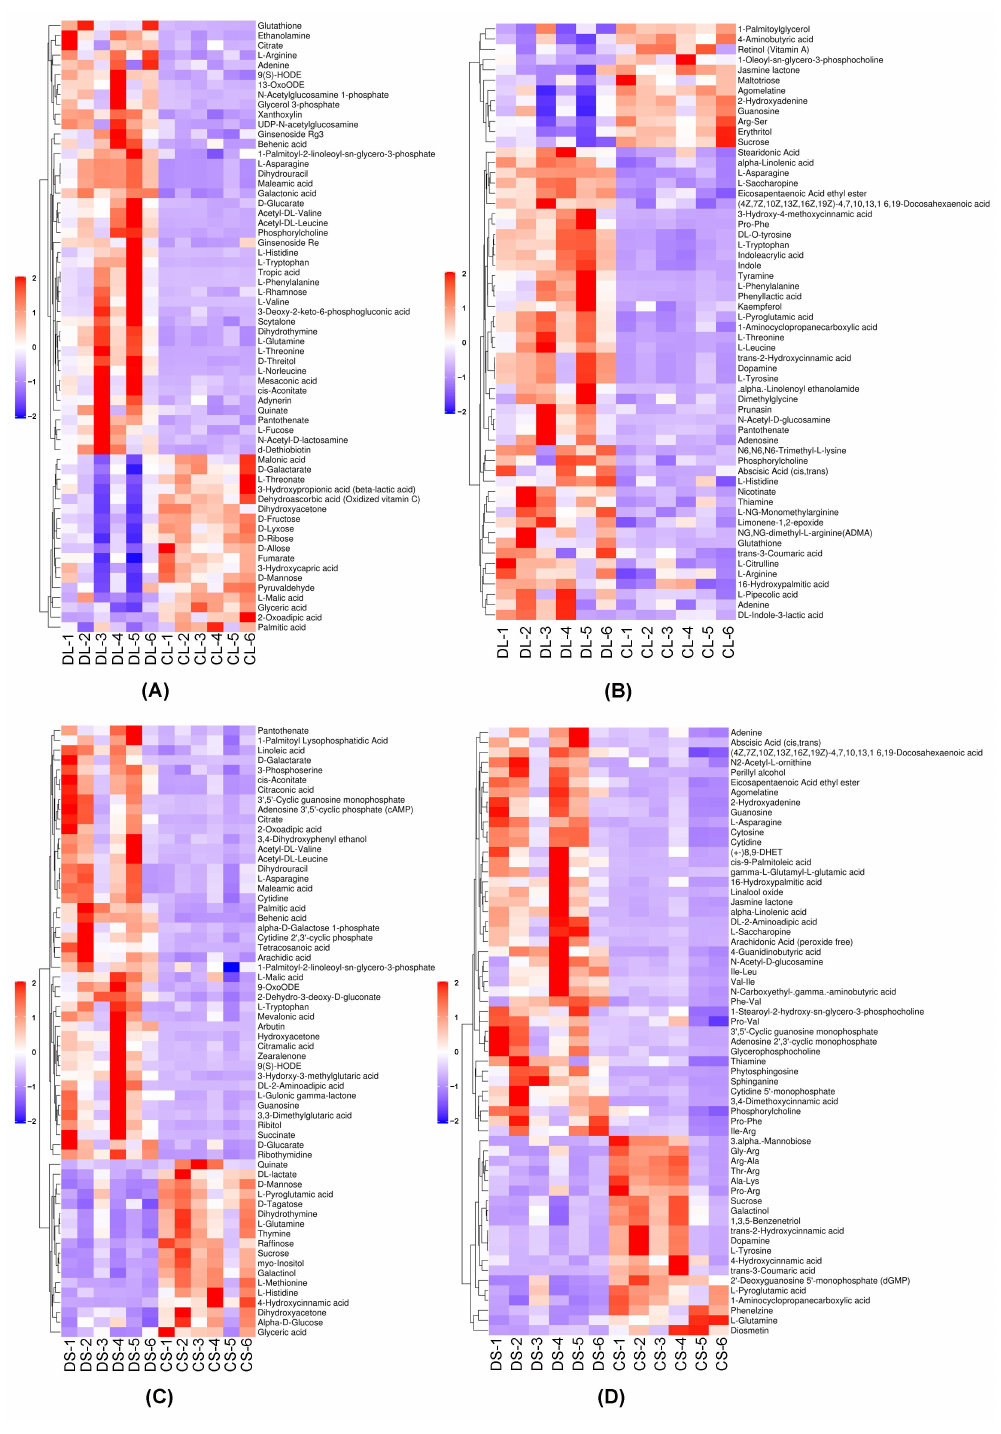
Figure 3. Heat plot of the differentially expressed metabolites of ginseng leaves and ginseng stems in negative ( A , C ) and positive mode ( B , D ). 2 and −2 depict the highest and the lowest relative in negative ( A , C ) and positive mode ( B , D ). 2 and − 2 depict the highest and the lowest relative abundance, respectively. abundance,